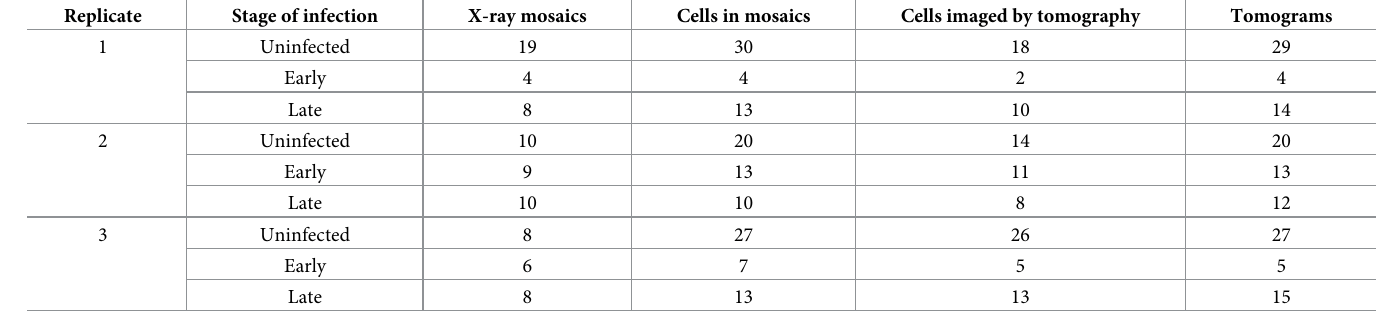
Table 1. Collection of cryoSXT data to analyse changes in cellular morphology accompanying infection. CryoSXT data was collected using a 25 nm zone plate from multiple uninfected cells or cells at early and late stages of infection across three independent replicates. Tiled X-ray projections (‘X-ray mosaics’) with a 66.2 × 66.2 μ m field of view were collected at multiple areas on the sample grid to identify cells of interest. Tilt series were collected at perinuclear or peripheral regions of the cytoplasm within these cells and were processed to generate tomograms.